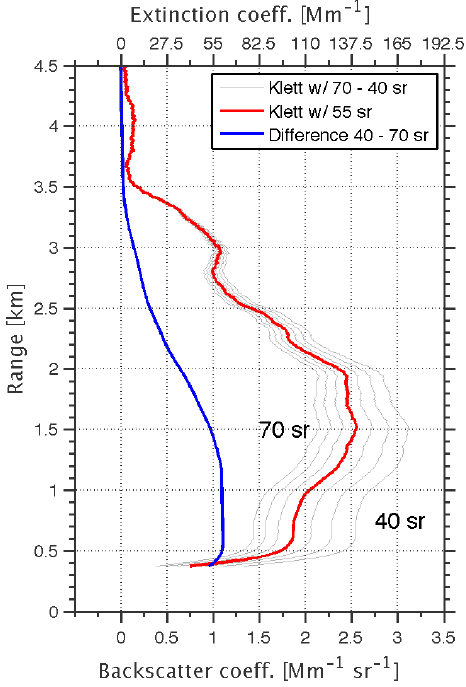
Figure 9. Backscatter coefficient obtained with the Klett algorithm using particle lidar ratios from 40 to 70sr in steps of 5sr (gray) and 41 the default inversion with 55sr (red) are shown. The difference of the backscatter obtained with 40 and 70sr (blue) is shown as an indication of the uncertainty. Data from 1 September 06:30p.m. to 2 September 05:00a.m. was used. The extinction scale on top was scaled with L p = 55